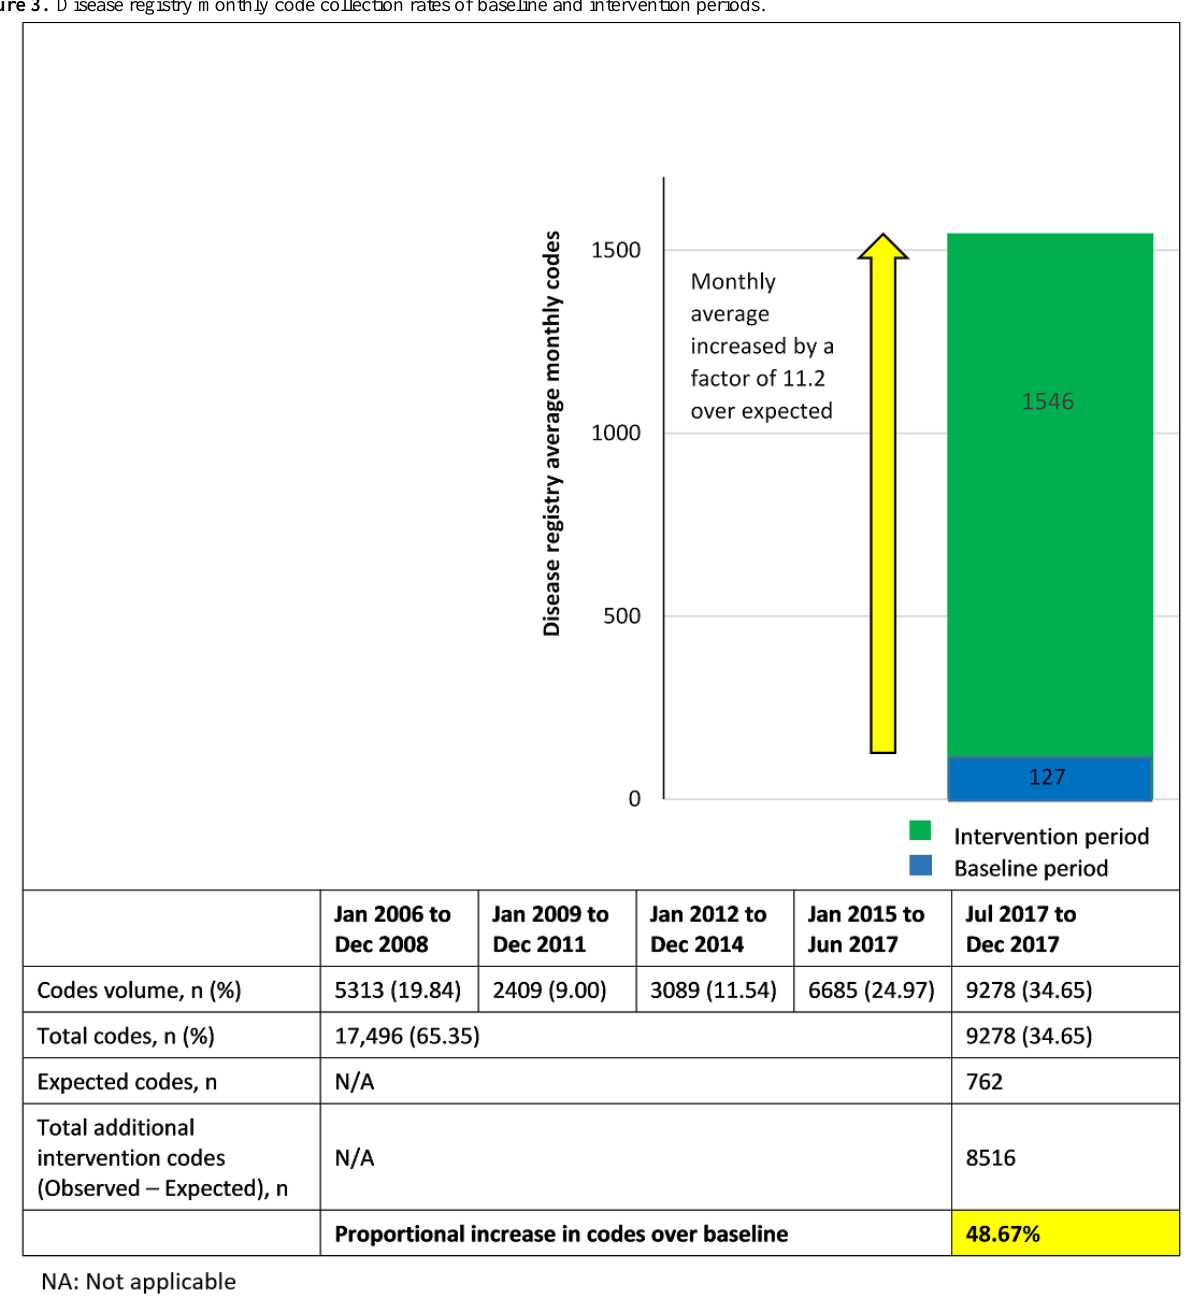
Figure 3. Disease registry monthly code collection rates of baseline and intervention